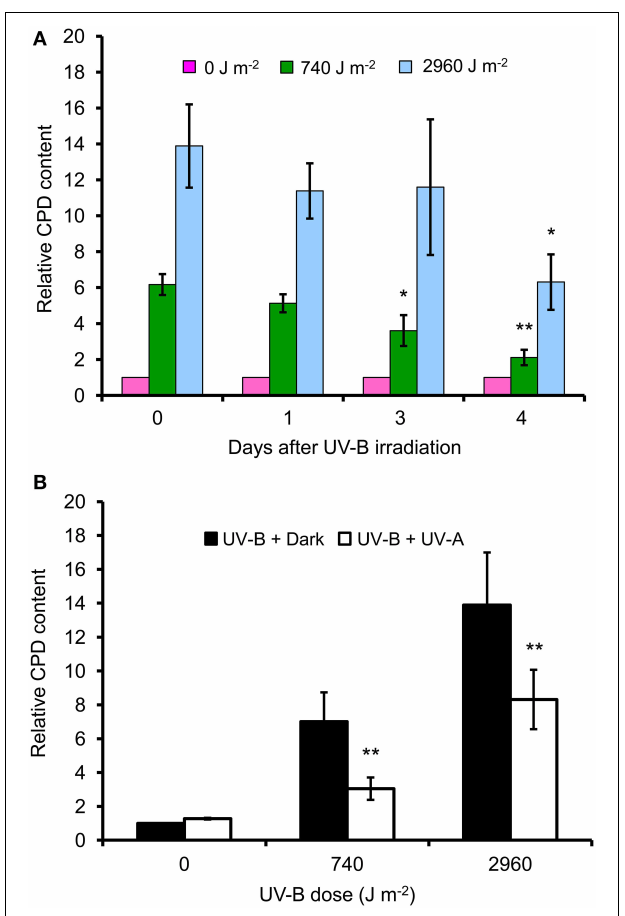
FIGURE 4 | Accumulation of cyclobutane pyrimidine dimers in UV-B–irradiated cells and reduction by UV-A radiation. Contents of cyclobutane pyrimidine dimers (CPDs) were measured by ELISA with CPD-specific antibody (BM12; Kyowa Medex Co., Japan). (A) The contents of CPD at 0, 1, 3, and 4 days after UV-B irradiation relative to that in non-irradiated cells. Error bars show SD ( n = 3 ). Asterisks indicate significant differences from the non-irradiated control ( * P < 0 . 05 , ** P < 0 . 01 ). (B) Amounts of CPDs in cells irradiated with UV-A immediately after UV-B exposure at indicated doses (0, 740, or 2960 J m − 2 ) relative to those in cells irradiated only with UV-B at 0 days after irradiation. Error bars show SD ( n = 3 ). Asterisks indicate significant differences from the UV-B + Dark treatment ( * P < 0 . 05 , ** P < 0 . 01 ).